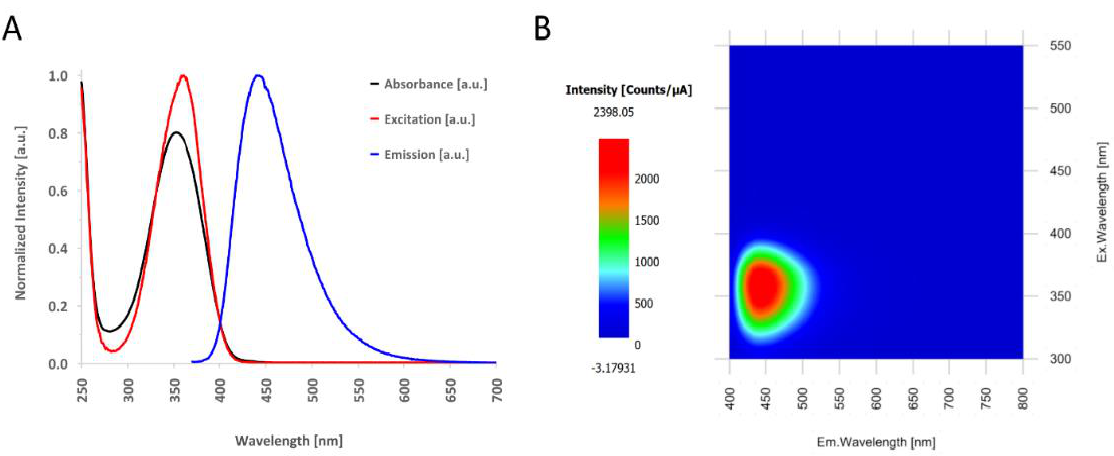
Figure 3. ( A ) The absorbance spectrum of the as-prepared CQDs solution (black), the excitation spectrum (red) and the